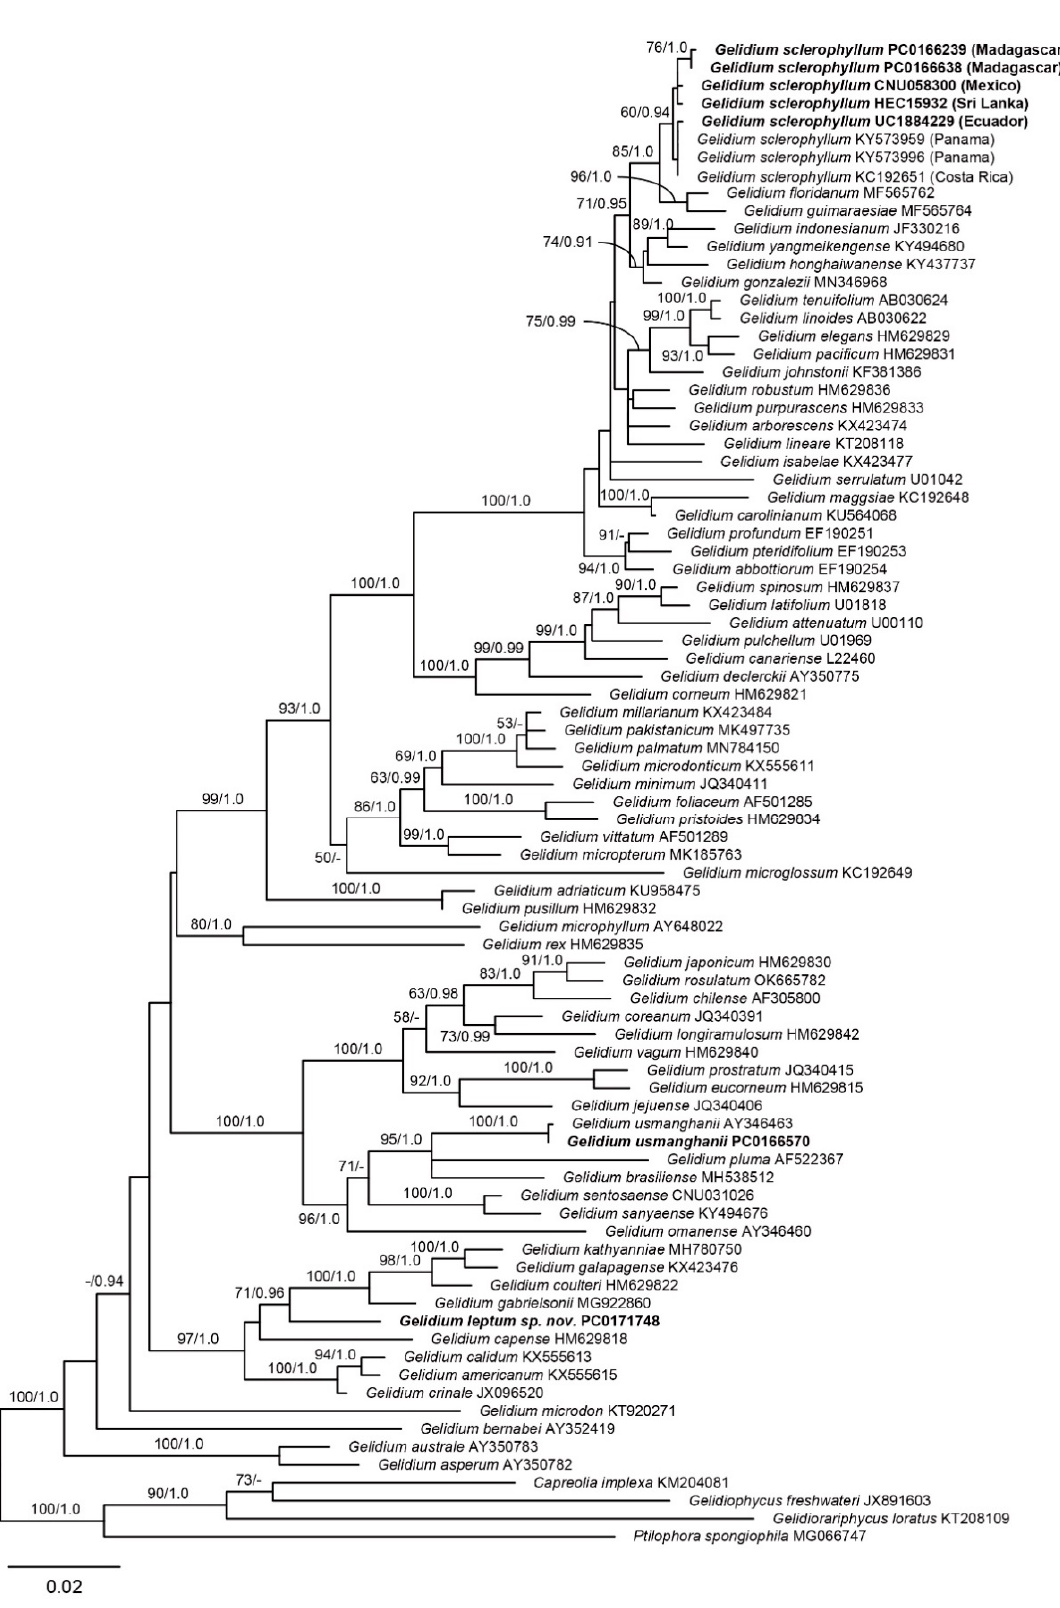
Figure 1. Maximum likelihood (ML) phylogeny of Madagascan Gelidium using plastid rbc L sequences. ML bootstrap values ( ≥ 50%) and Bayesian posterior probabilities ( ≥ 0.90) are shown at branches. Dash indicates values <50 or <0.90. Bold letter indicates newly generated sequences in the present study.